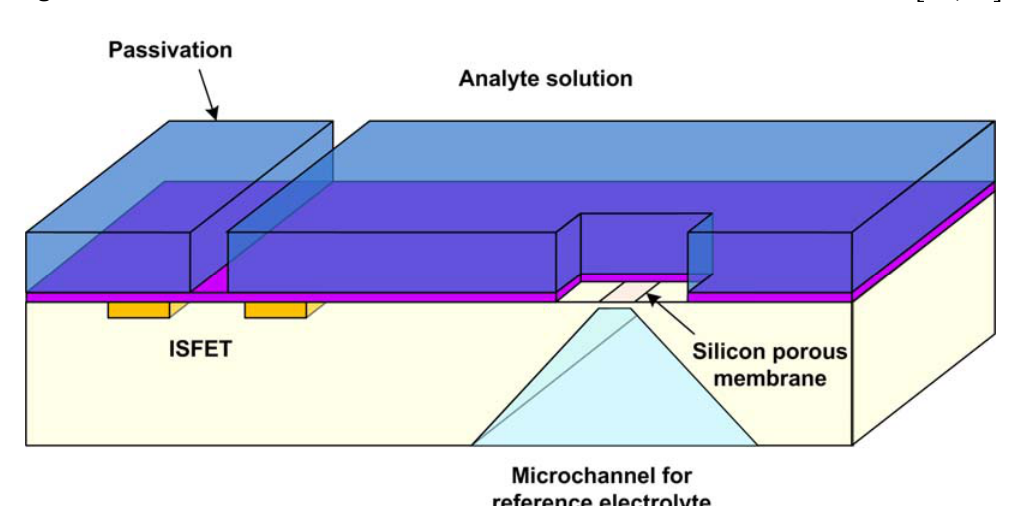
Figure 8. Bulk micromachined reference electrode channel and membrane